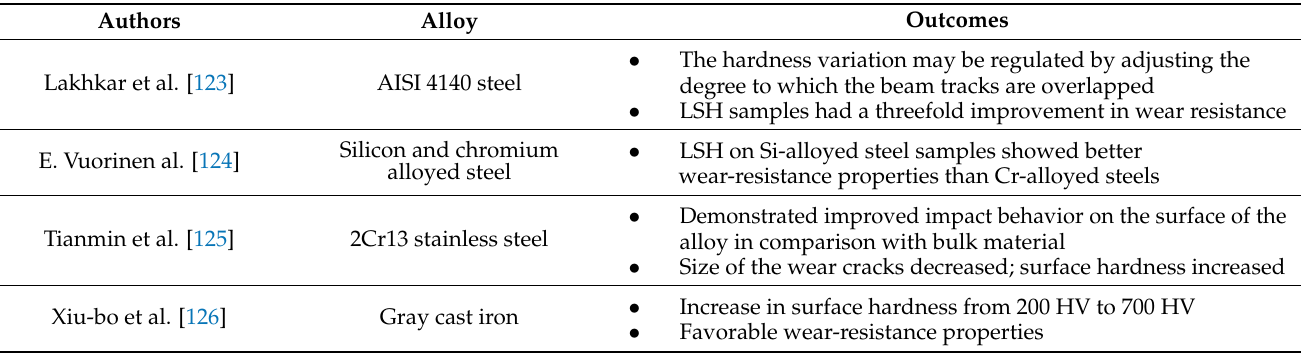
Table 8. LSH treatment on metallic